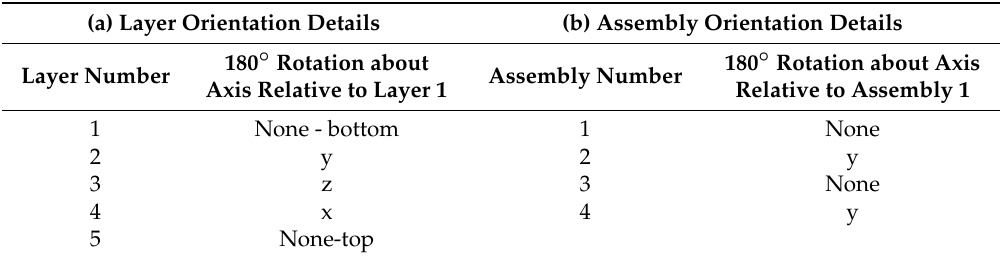
Table 1. Orientation details for the layers and assemblies of the artificial riverbed.